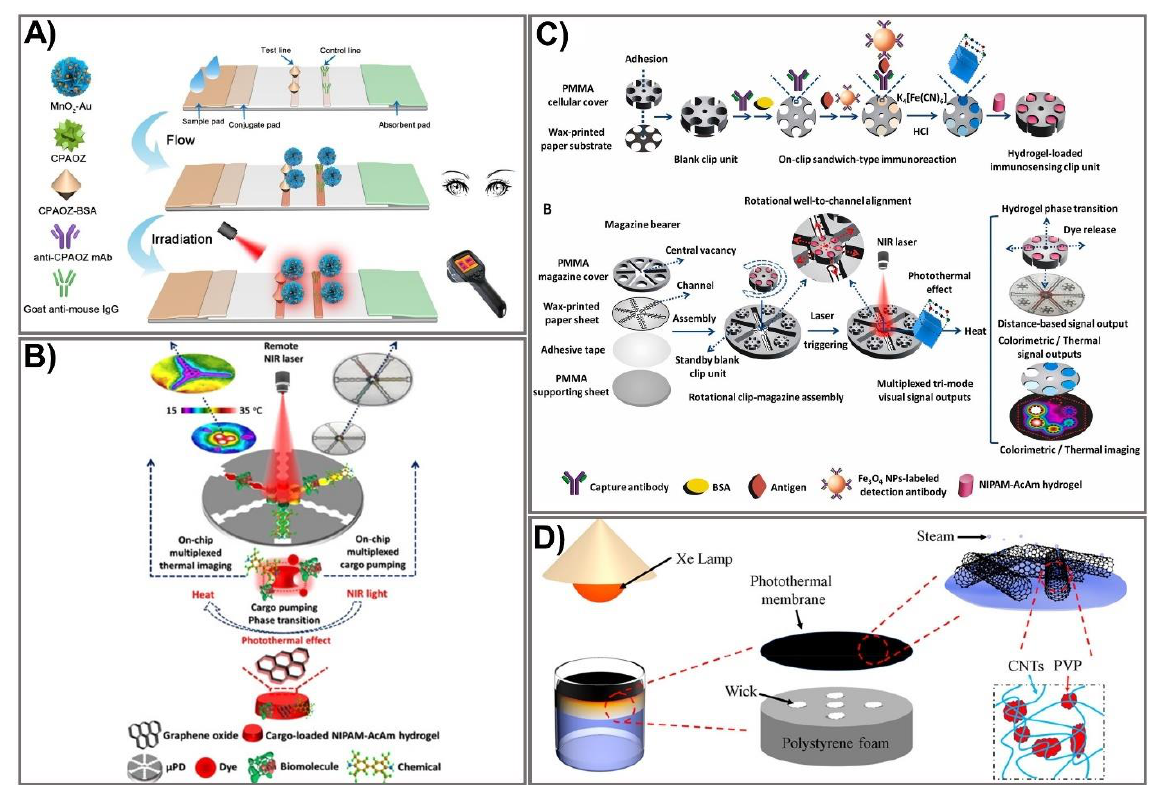
Figure 5. Schematic design of an amplified PAD signal using photothermal-based techniques. ( A ) Schematic representation of the MnO 2 -Au-based dual-signal immunoassay for AOZ detection. Adapted with permission from Ref. [100] . ( B ) Principle of photothermal microfluidic pumping-based PAD fabrication. Adapted with permission from Ref. [102] . ( C ) The design of the clip-magazine-assembled photothermal biosensing disk for tri-mode visual quantification of prostate-specific antigen. Adapted with permission from Ref. [103] . ( D ) Schematic demonstration of CNT@PVP photothermal membrane-based solar steam-generation device fabrication for water desalination. Adapted with permission from Ref. [104] .